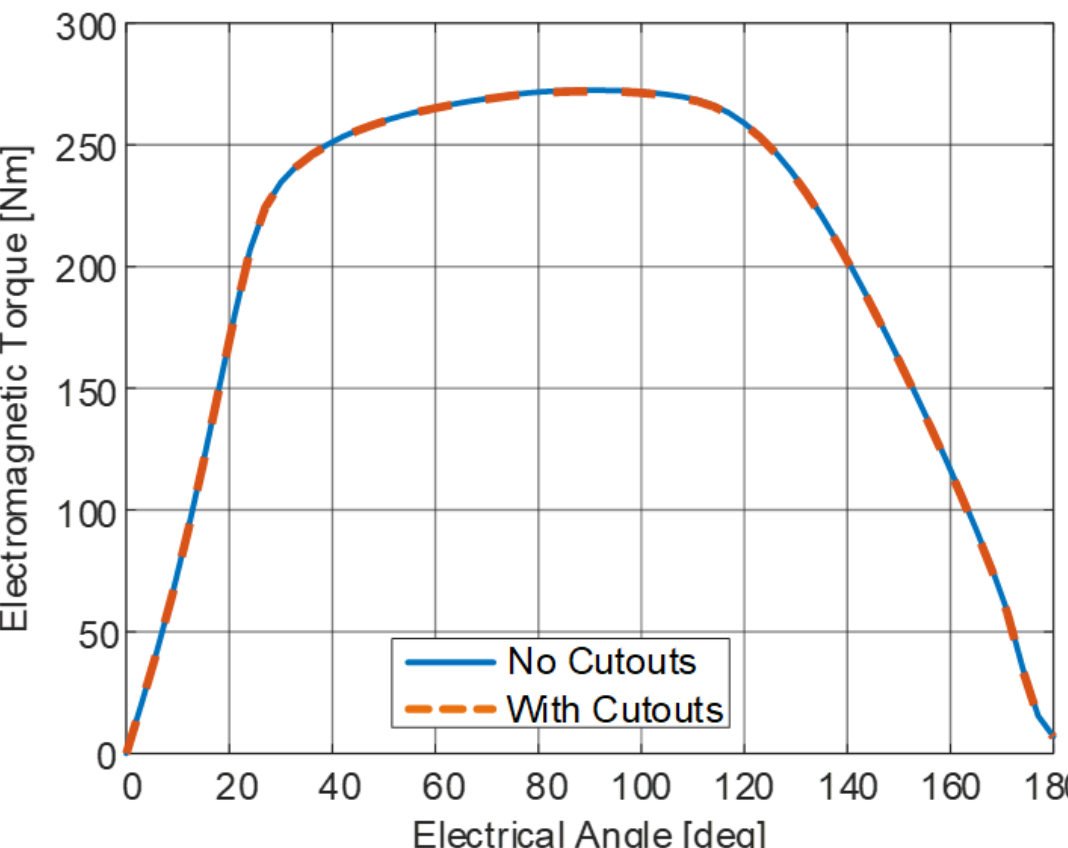
Figure 16. Static torque for half of an electrical cycle with 195 A current reference before and after rotor cutouts.